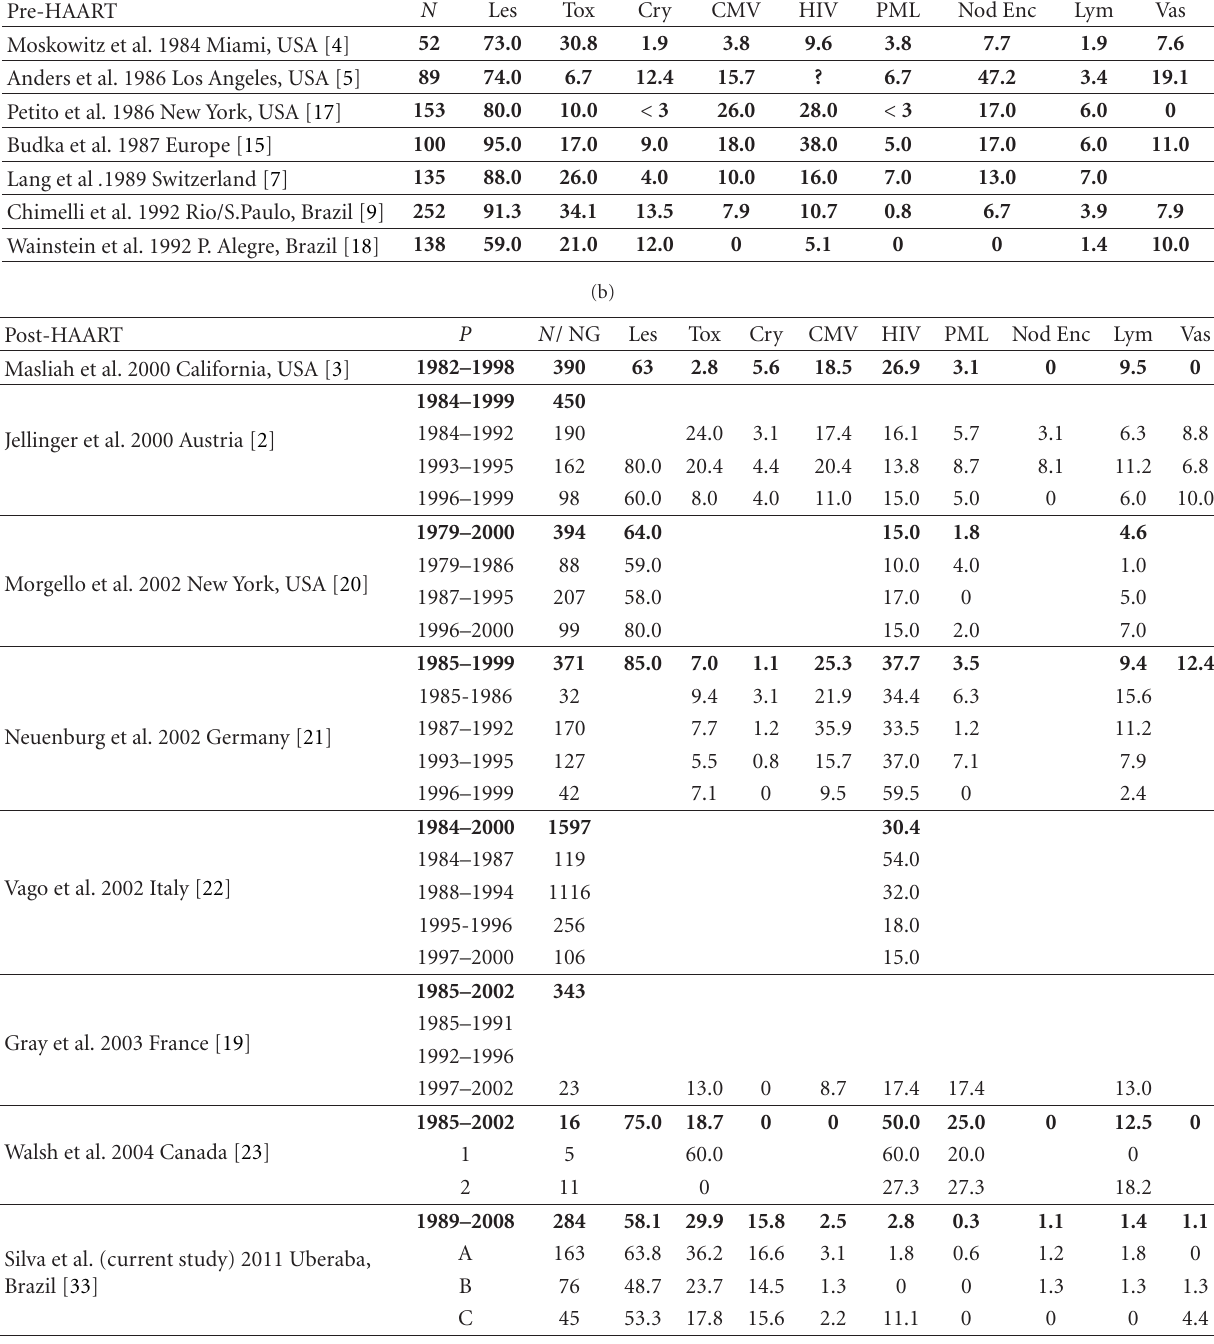
Table 3: Comparison between di ff erent studies regarding lesions to the central nervous system, in a series of autopsies of patients with HIV